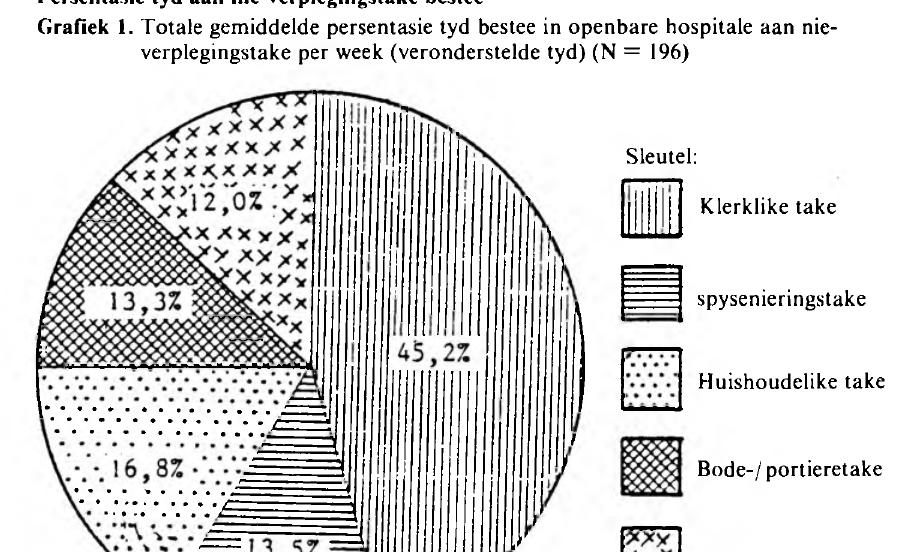
Grafiek 2. Totale gemiddelde persentasie tyd bestee in openbare hospitale aan